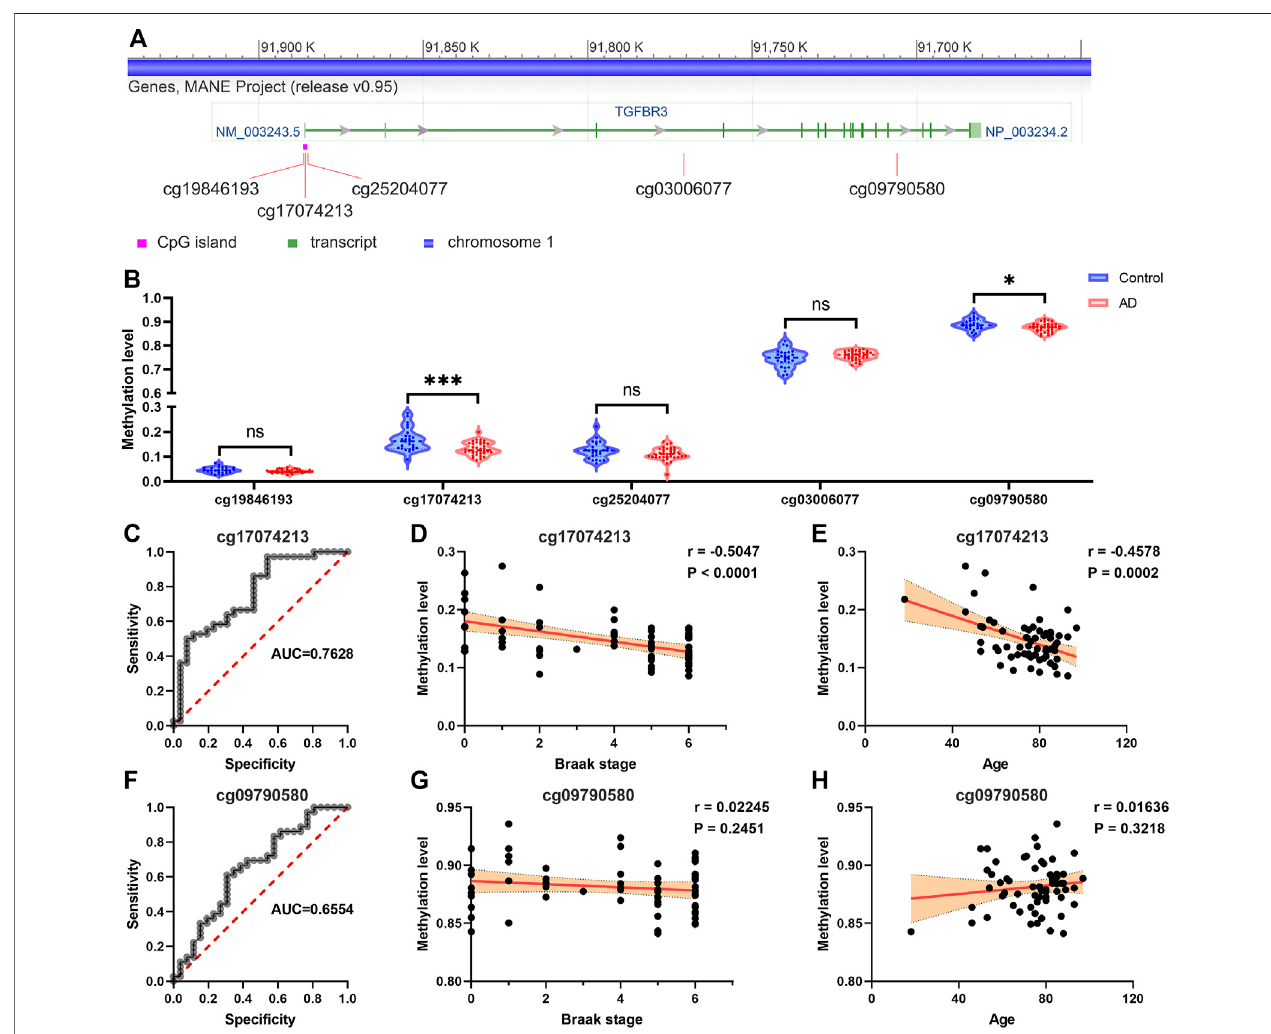
FIGURE 5 | The promoter methylation level of TGFBR3 was reduced in AD and negatively correlated with advanced Braak stage (A) The methylation probes of TGFBR3(NM_003,243.5)annotatedbytheUSUCgenomebrowser (B) MethylationlevelsofmethylationprobesforTGFBR3inADtissuesandcontrolsfrommethylation dataset 1 (C) The ROC curves for predicting AD by the cg17074213 (D) The correlation analysis of cg17074213 level and Braak stage (E) The correlation analysis of cg17074213 level and age (F) The ROC curves for predicting AD by the cg09790580 (G) The correlation analysis of cg09790580 level and Braak stage (H) The correlation analysis of cg09790580 level and age. ns: not signi fi cant, * p < 0.05, *** p < 0.001.